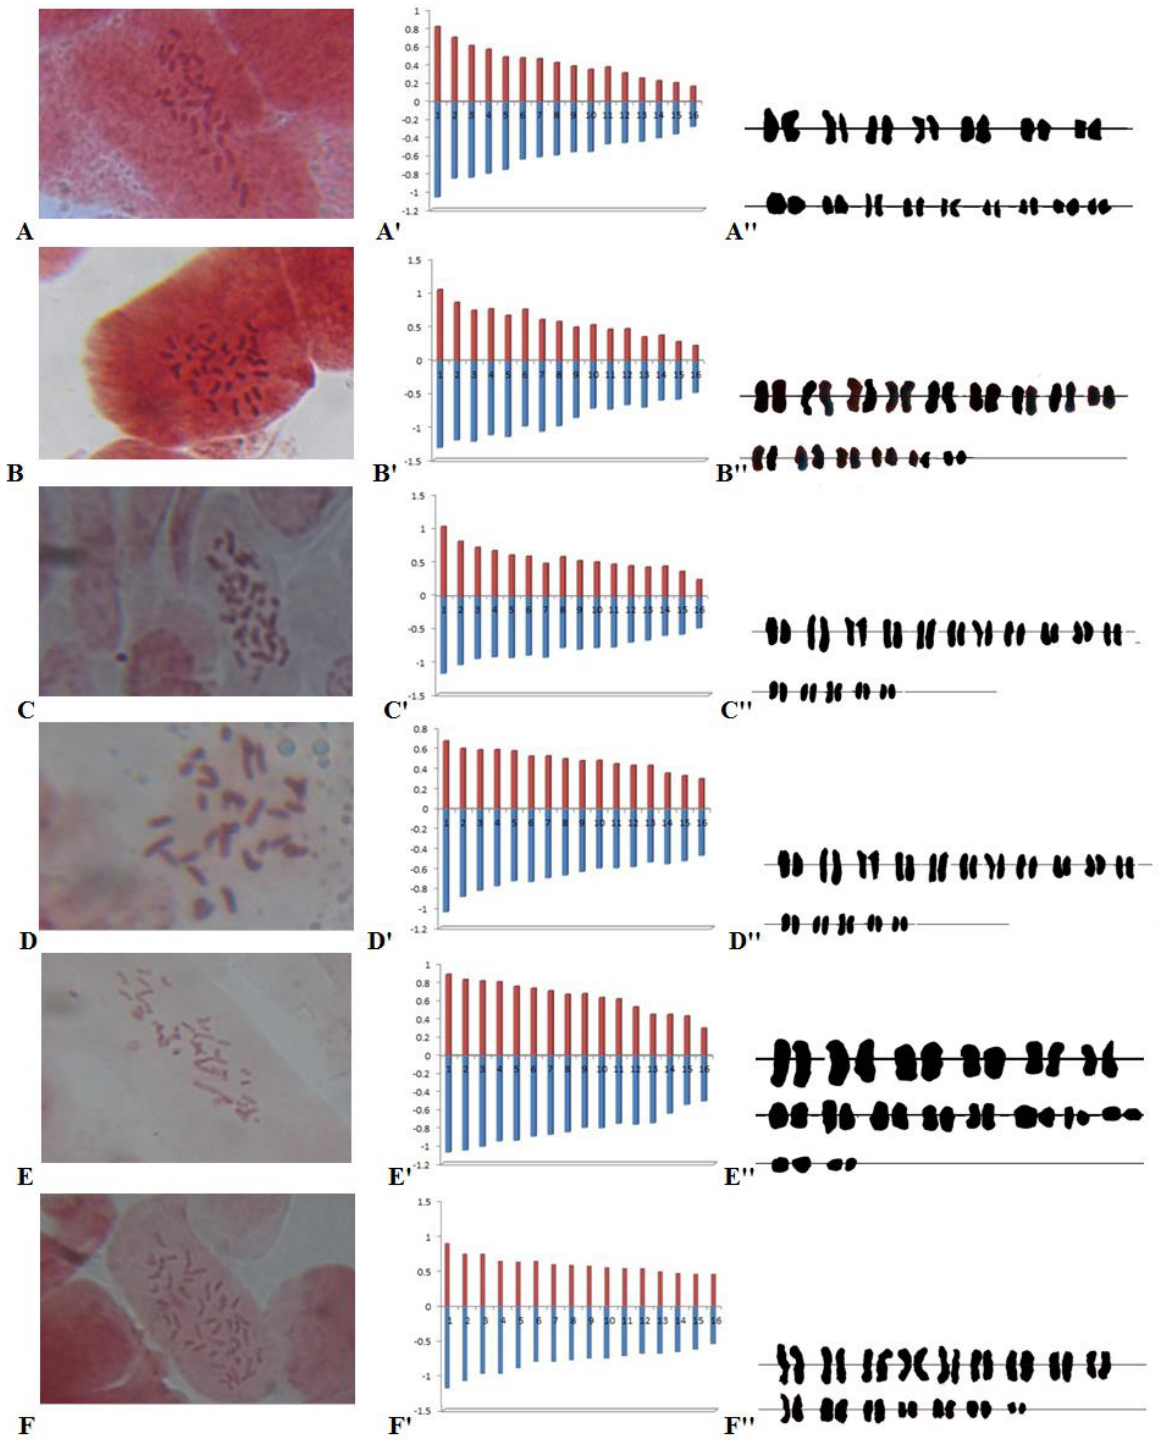
Fig. 1. Karyotypes, idiograms and karyograms of 6 populations of C. officinalis : A) Karaj; B) Masjed Soleyman 1; C) Masjed Soleyman 2; D) Khuzestan 1; E) Khuzestan 2; F) Khuzestan 3; A’) Karaj; B’) Masjed Soleyman 1; C’) Masjed Soleyman 2; D’) Khuzestan 1; E’) Khuzestan 2; F’) Khuzestan 3; A’’) Karaj; B’’) Masjed Soleyman 1; C’’) Masjed Soleyman 2; D’’) Khuzestan 1; E’’) Khuzestan 2; F’’) Khuzestan